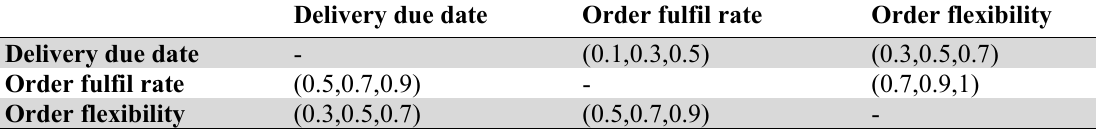
Paired-wise comparison of delivery sub-criteria